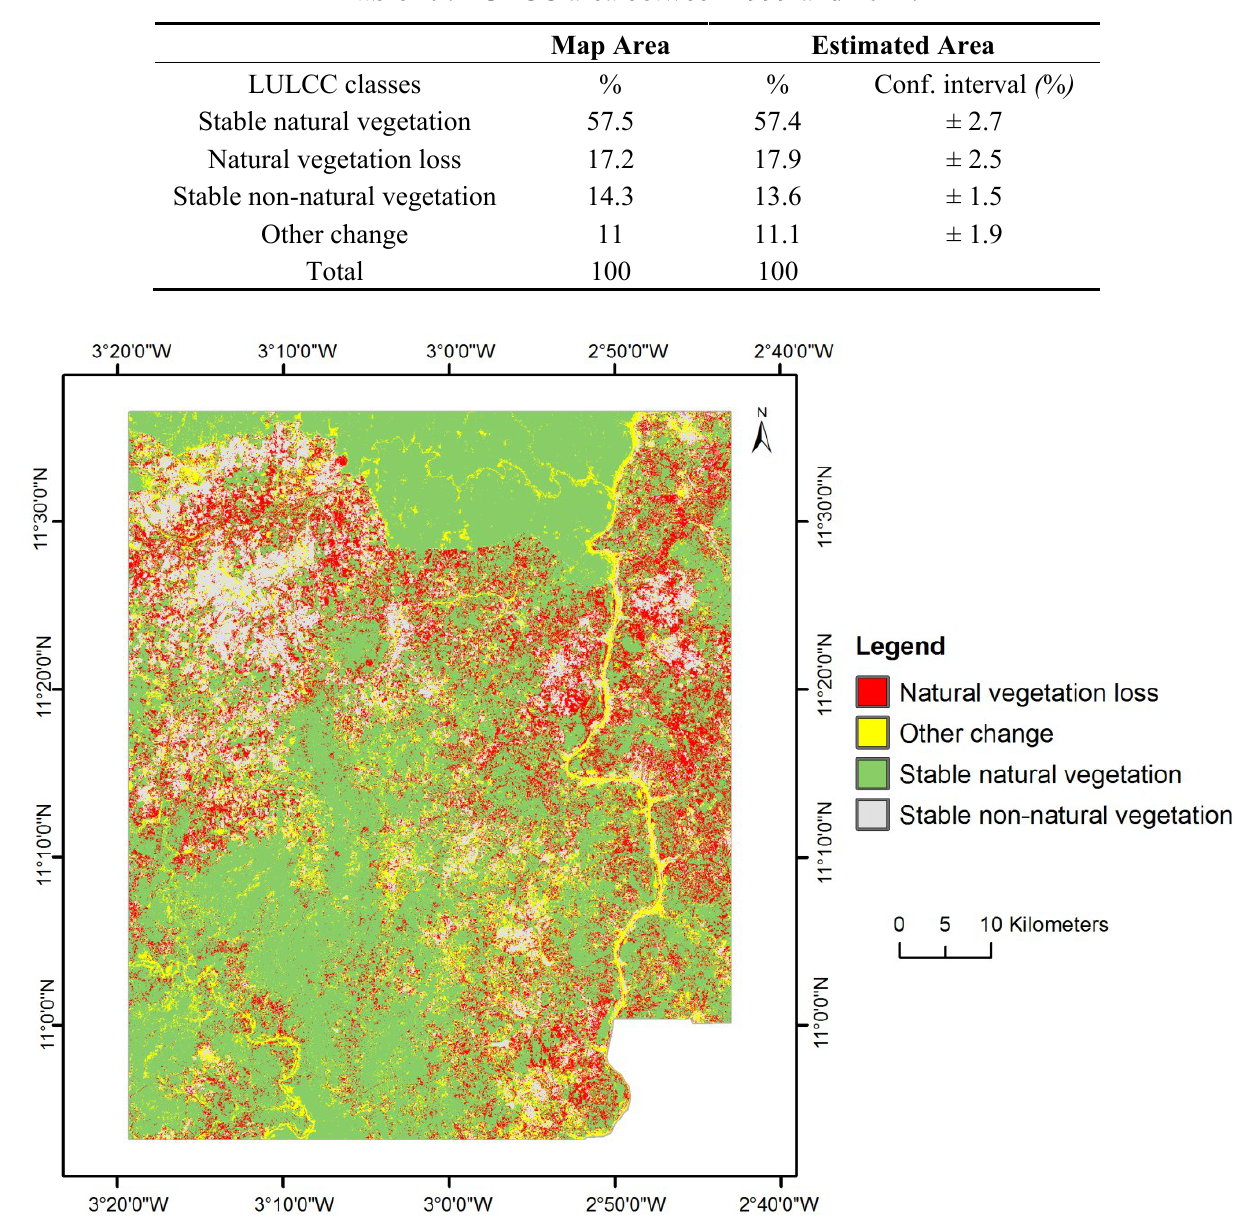
Table 19. LULCC area between 1999 and 2011.